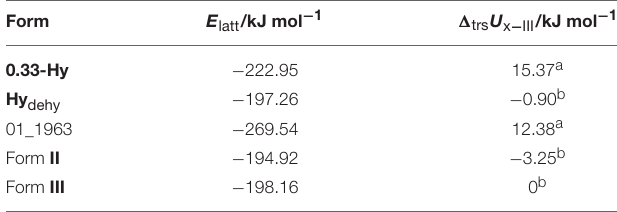
TABLE 1 | Lattice energy calculations ( E latt ) of 0.33-Hy , 01_1963, forms II and III and the isomorphic dehydrate structure ( 0.33-Hy without water molecules, Hy dehy ) and potential energy differences ( 1 trs U ) with respect to form III